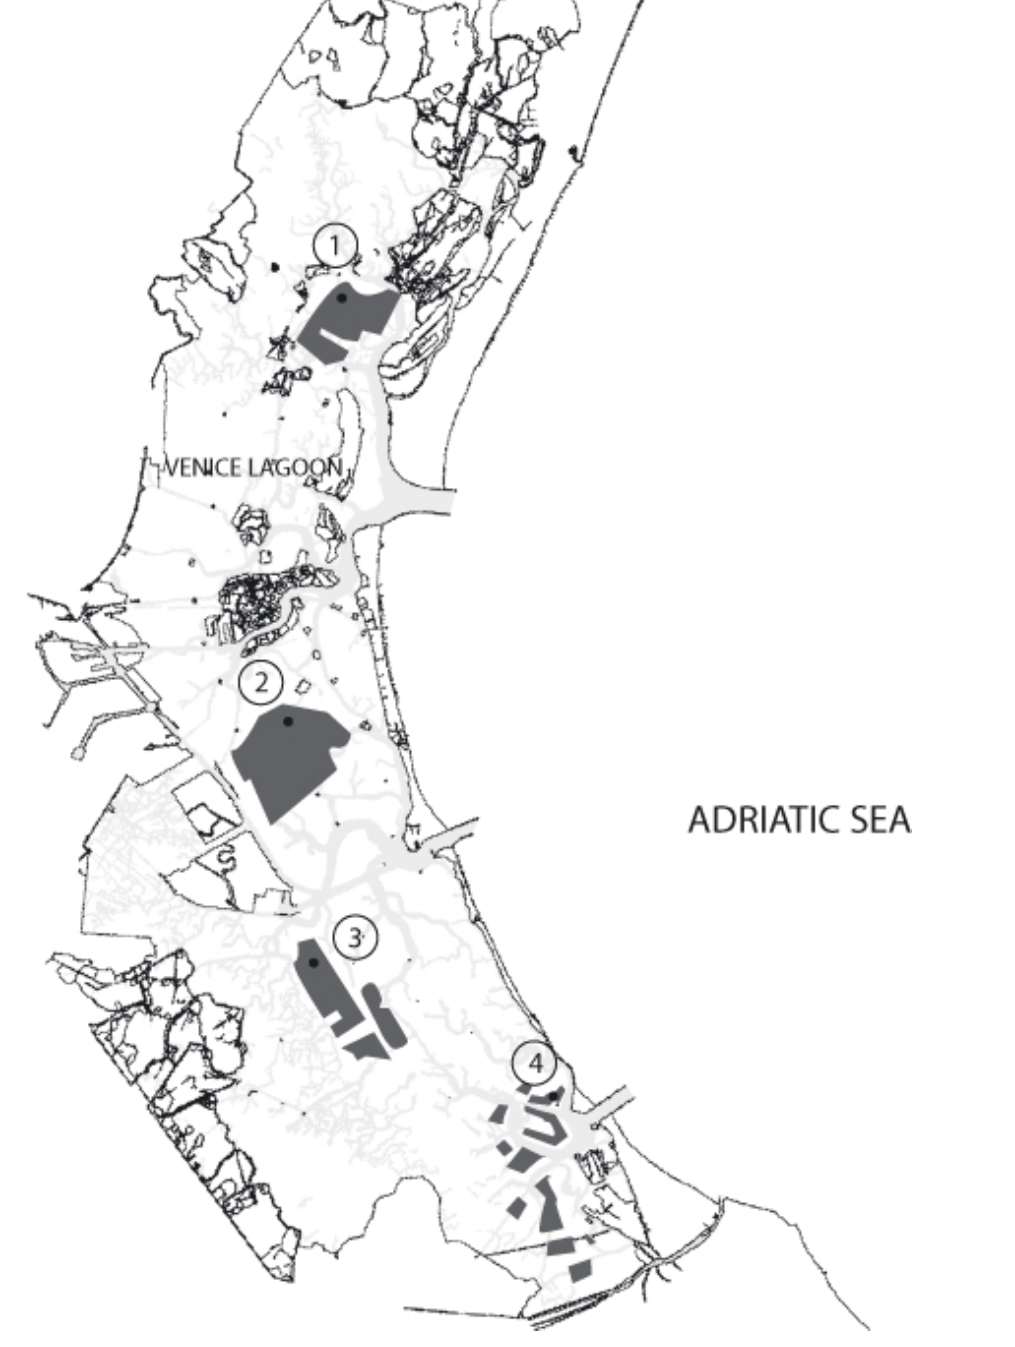
Fig. 5. The Venice Lagoon and position of concession areas. Numbers 1-4 identify the simulated area